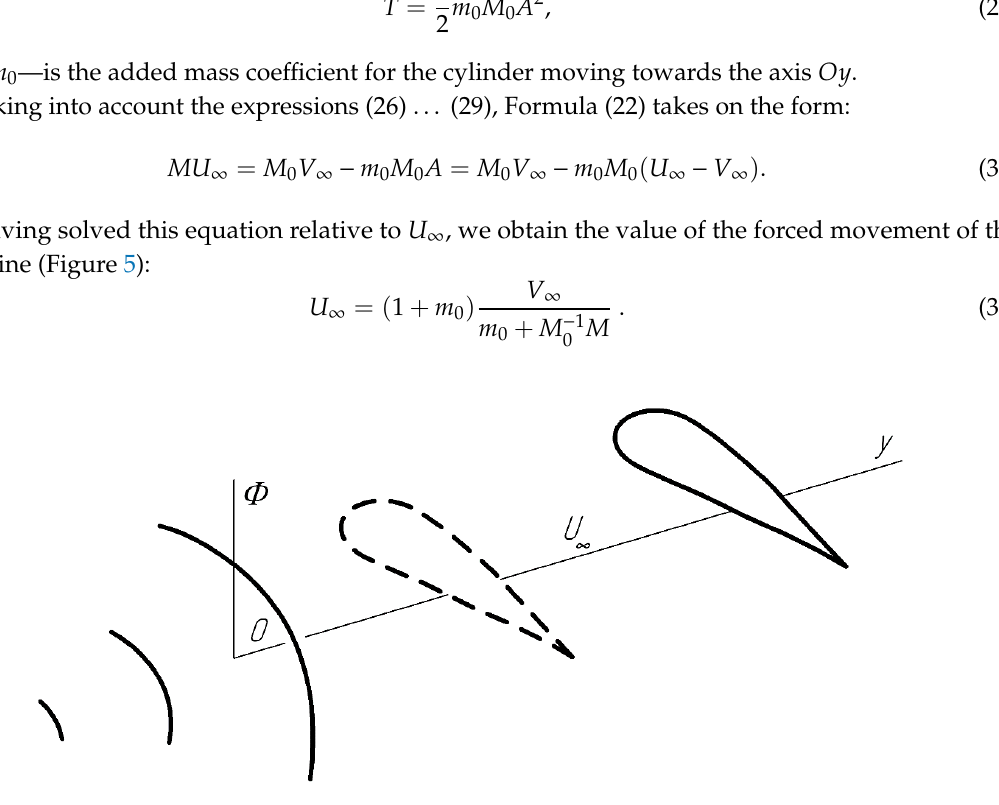
ff ected by the acoustic